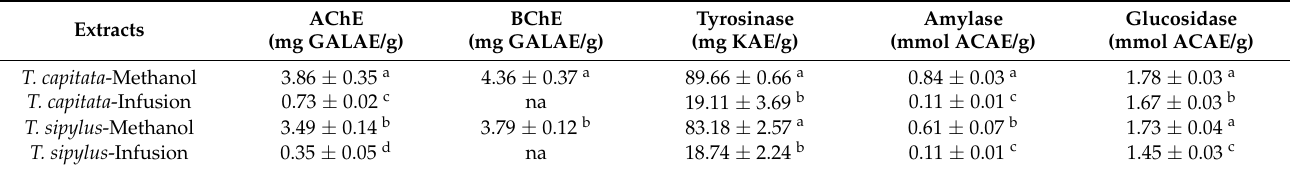
Table 6. Enzyme inhibitory properties of tested